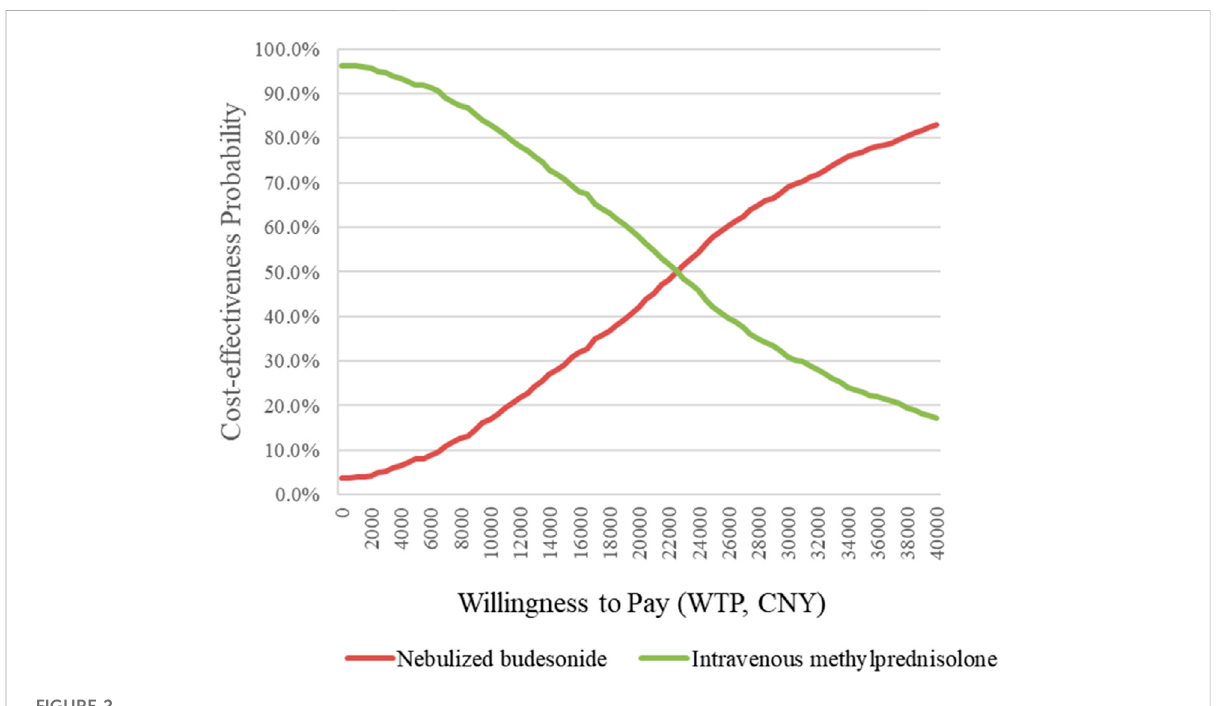
FIGURE 2 CEAC by bootstrap analysis on the rate of no readmission